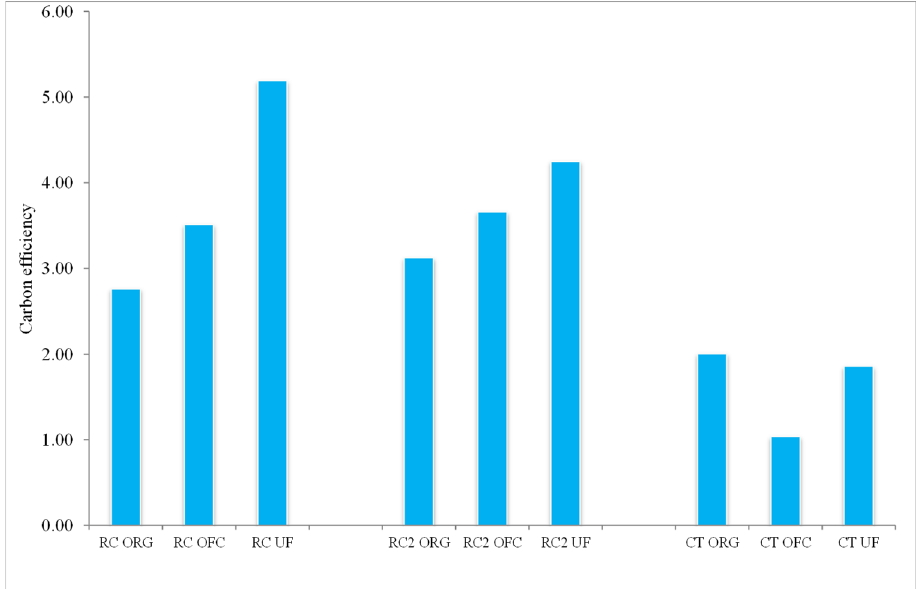
Figure 6. Carbon efficiency in the different analyzed systems. RC = mix of vetch-oats; RC2 = mix of vetch-rice; CT = no cover crops; ORG = organic commercial fertilizer; OFC = on-farm compost; UF = unfertilized control.